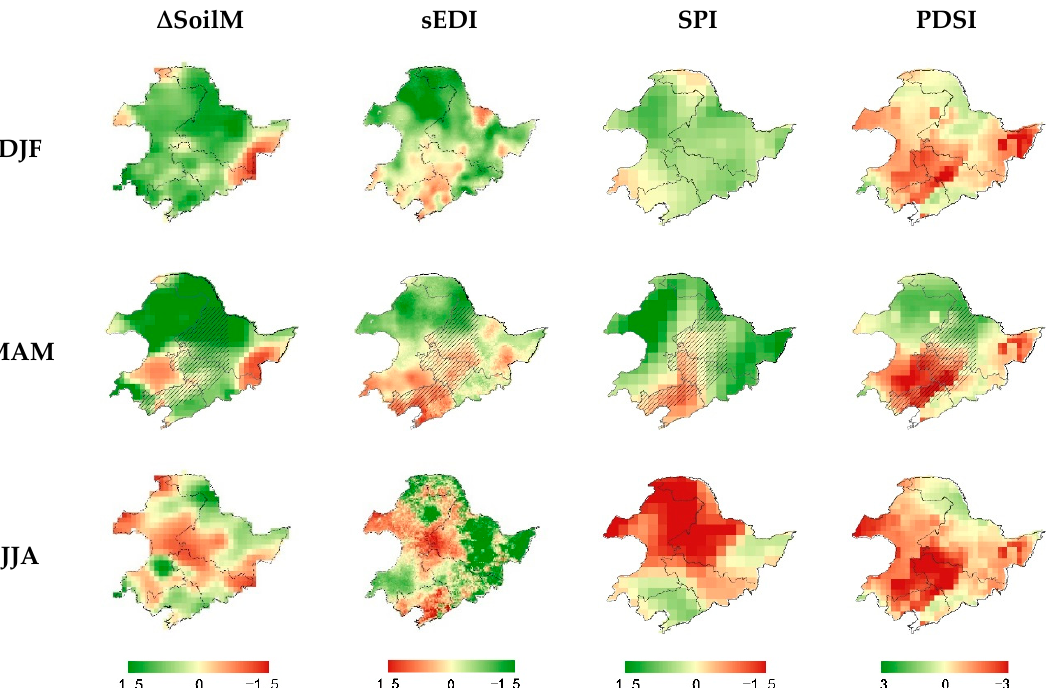
Figure 5. Seasonal standardized anomalies in SoilM, EDI, SPI, and PDSI from December 2003 to August 2004, where DJF means Dec, Jan, and Feb; MAM means Mar, Apr, and May; JJA means Jun, Jul, and Aug; SON means Sep, Oct, and Nov. Green indicates wetness and red indicates dryness. The dashed line refers approximately to a recorded dry patch.